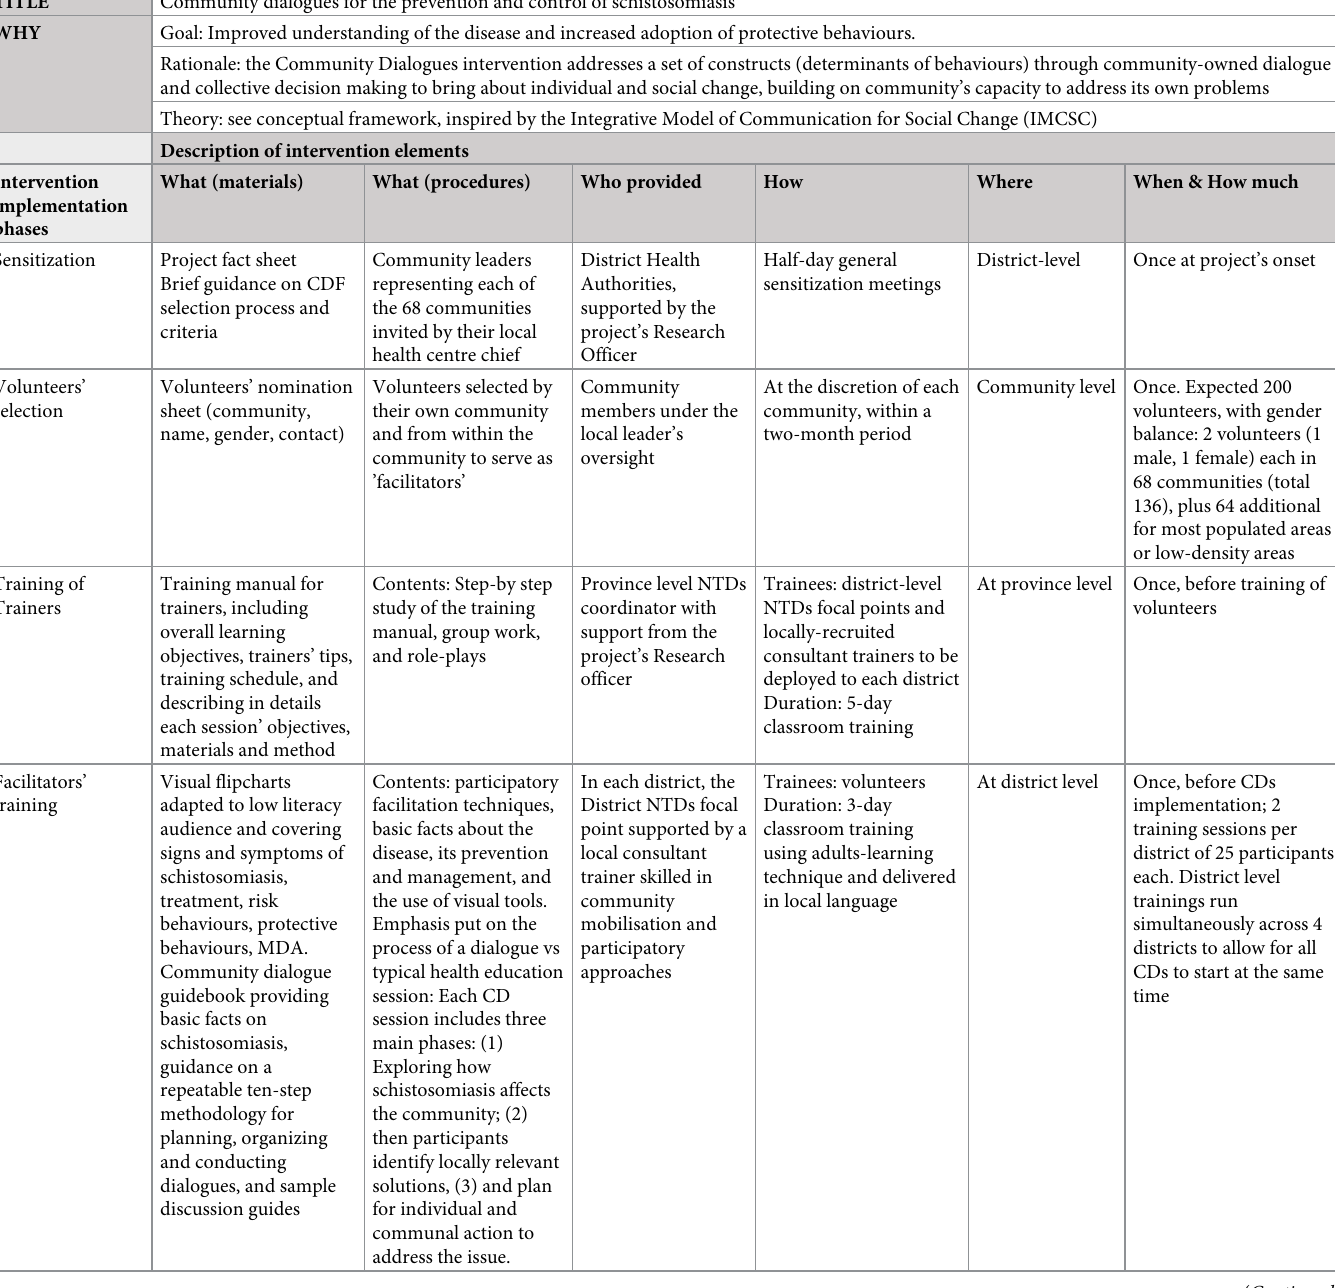
Table 1. Intervention description. Community dialogues for the prevention and control of schistosomiasis Goal: Improved understanding of the disease and increased adoption of protective behaviours. Rationale: the Community Dialogues intervention addresses a set of constructs (determinants of behaviours) through community-owned dialogue and collective decision making to bring about individual and social change, building on community’s capacity to address its own